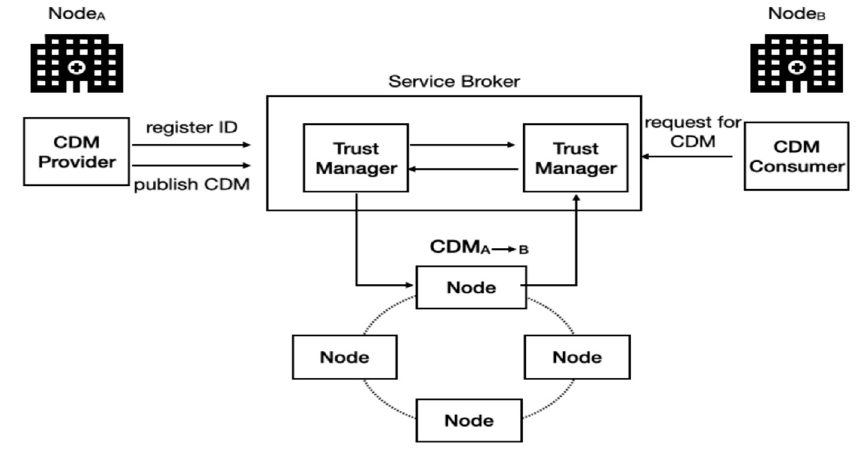
Figure 3. CDM delivery process .